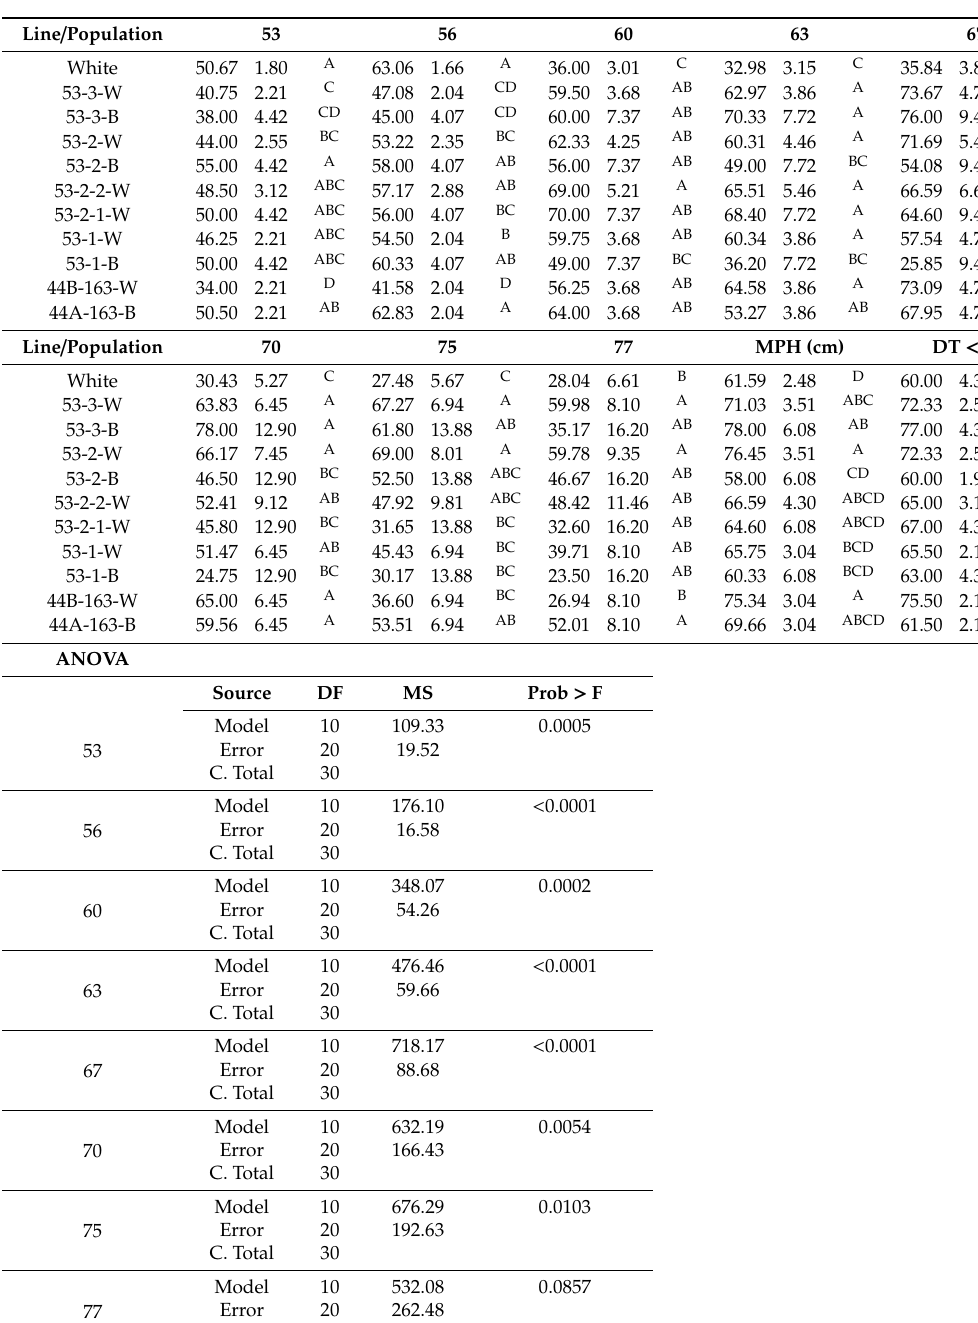
Table 5. LS means for plant height in centimeter, measured along the reproductive phase (53–77 DAS). MPH (Maximal Plot Height), DT < 75% in 11 lines under field conditions, as well as ANOVA for each of the